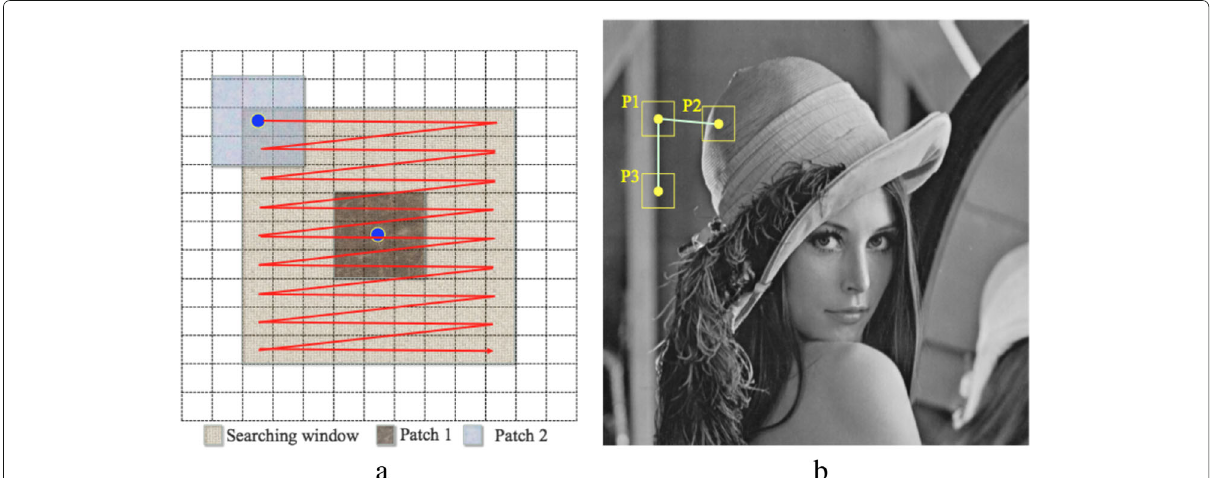
Fig. 2 Similarity between patches. a NL-Means patches as a raster scan in a search window. b Patch P3 is similar to P1 more than patch P2; hence, P3 will get a weight larger than P2 weight